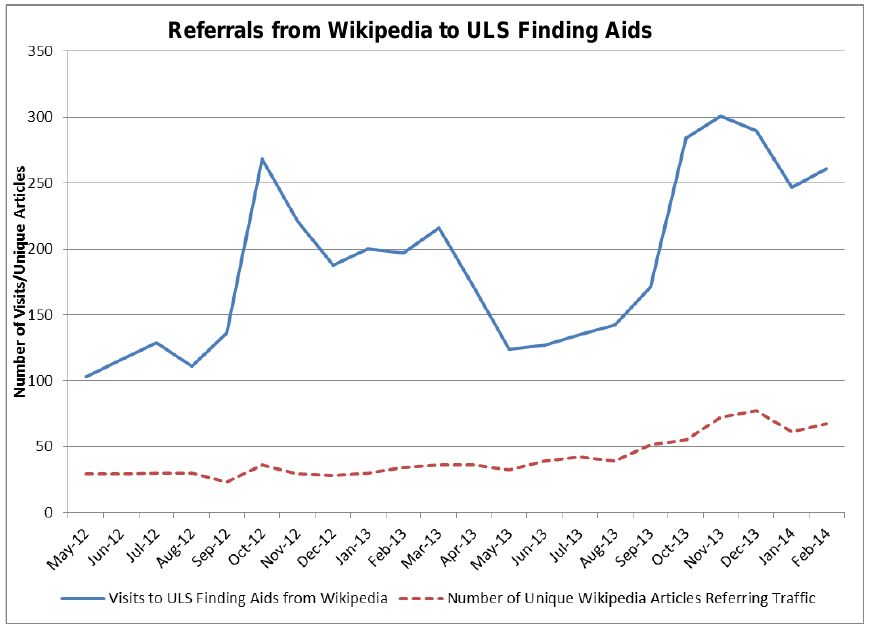
Referrals from Wikipedia to ULS finding aids, May 2012 through February